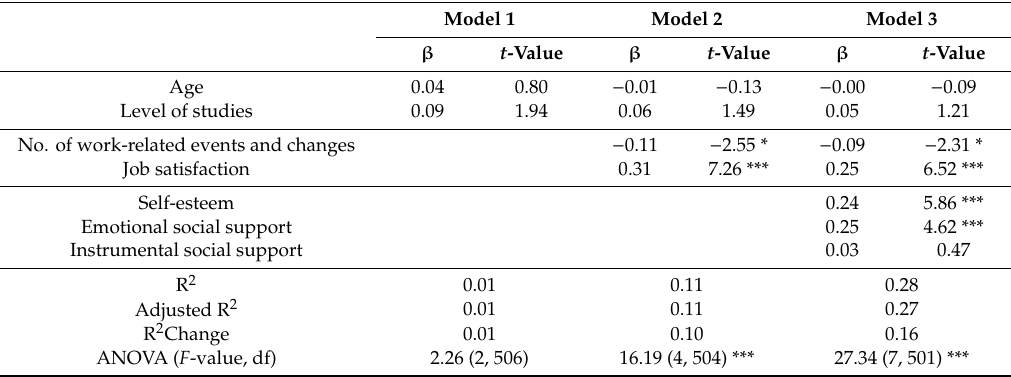
Table 4. Summary of the hierarchical multiple regression analysis with life satisfaction as a dependent variable for the male sample.